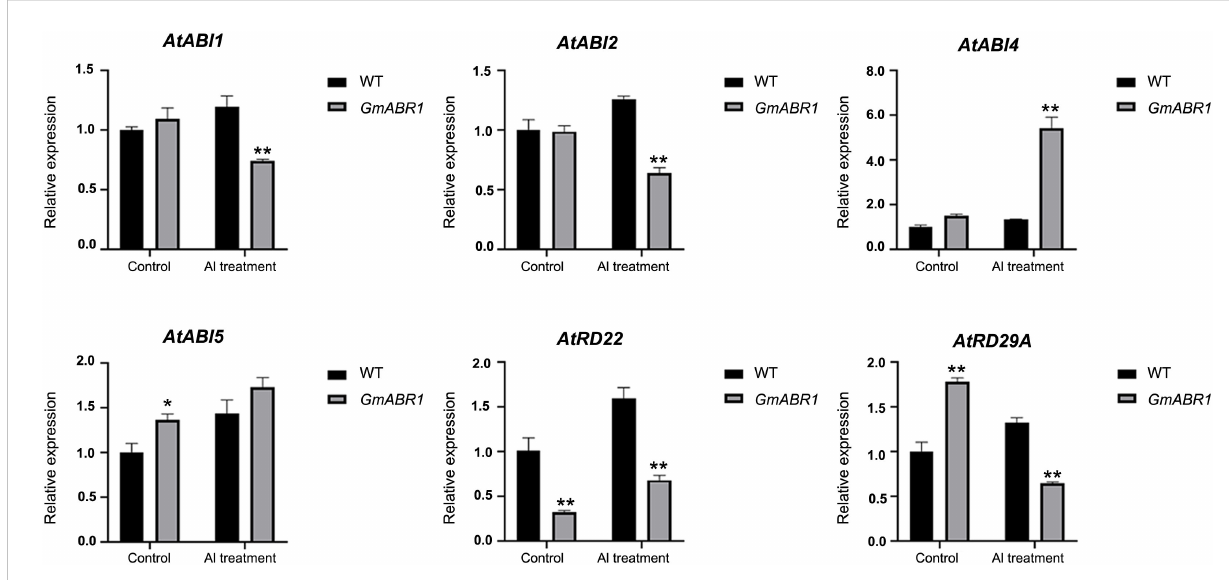
FIGURE 7 Expression patterns of ABA-responsive genes regulated by GmABR1 in Arabidopsis. Arabidopsis were cultured in solid medium supplemented with 0 and 100 m M AlCl 3 (pH4.5) for 7 days, respectively. The expression patterns of Al stress responsive genes by GmABR1 were detected. Using Arabidopsis Tubulin as the internal reference gene, qRT-PCR was used to detect the gene expression level before and after Al treatment. The asterisks indicated that the transcripts of investigated genes in GmABR1 transgenic lines were signi fi cantly different from those of WT treated with and without AlCl 3 ( *P < 0.05; **P < 0.01). The information of gene sequences was from the NCBI database (https://www.ncbi.nlm.nih.gov/). qRT-PCR primer information used in this experiment was shown in Table